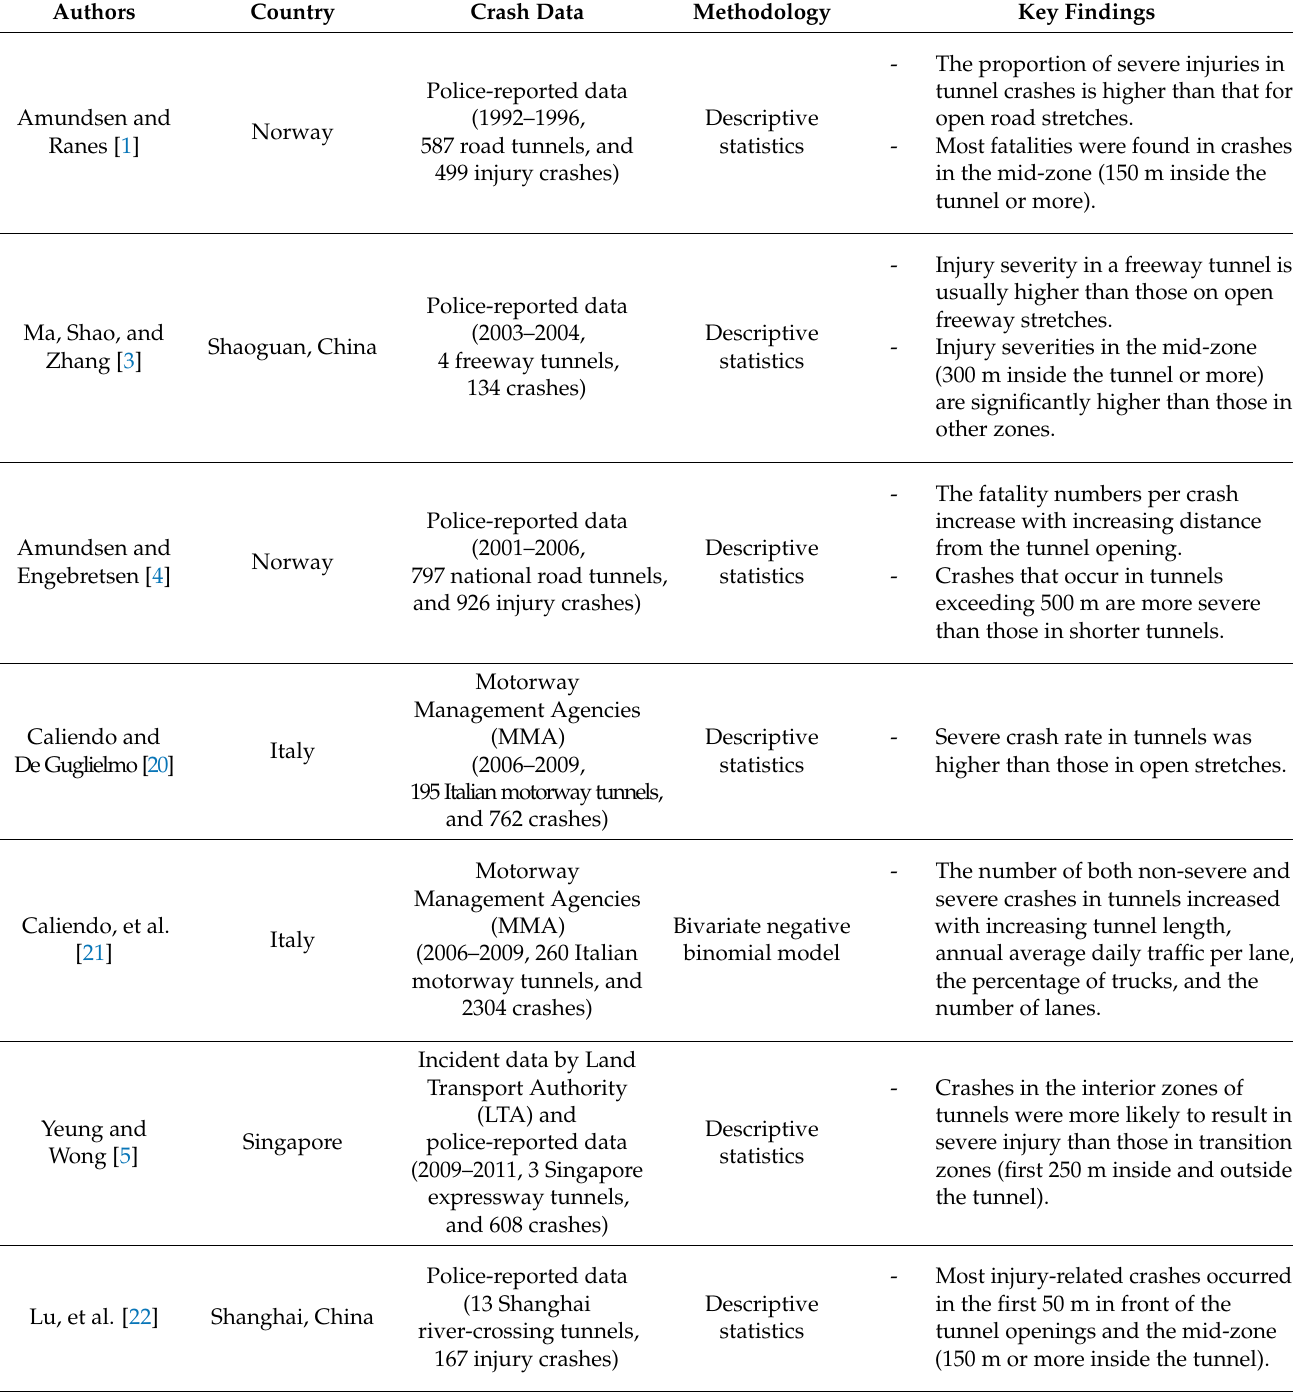
Table 1. Summary of studies analyzing the injury severity of tunnel